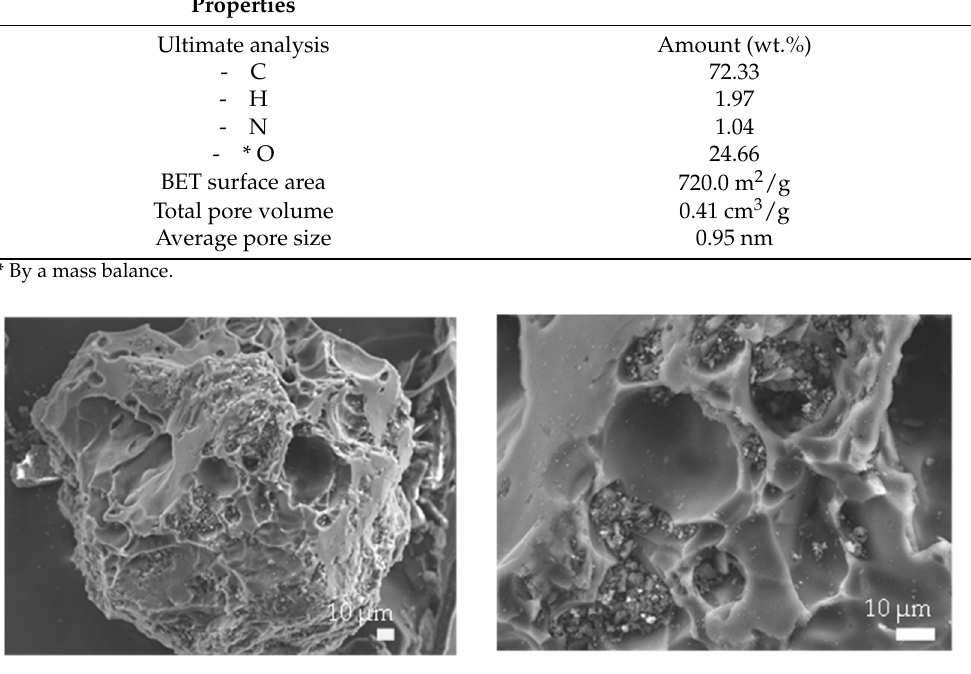
Figure 3. SEM images of activated carbon used in this